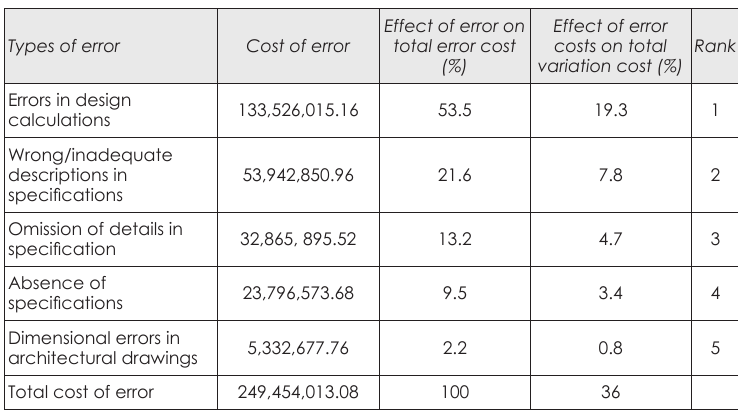
Table 11: Effects of design errors on variation cost based on types of